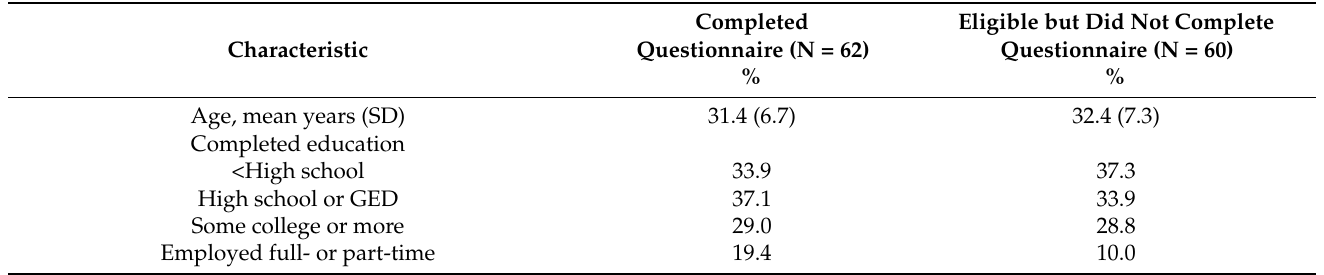
Table 1. Baseline sociodemographic characteristics for American Indian participants of the NCARE CHOICES study who were eligible to complete a COVID-19 supplemental questionnaire, according to completion